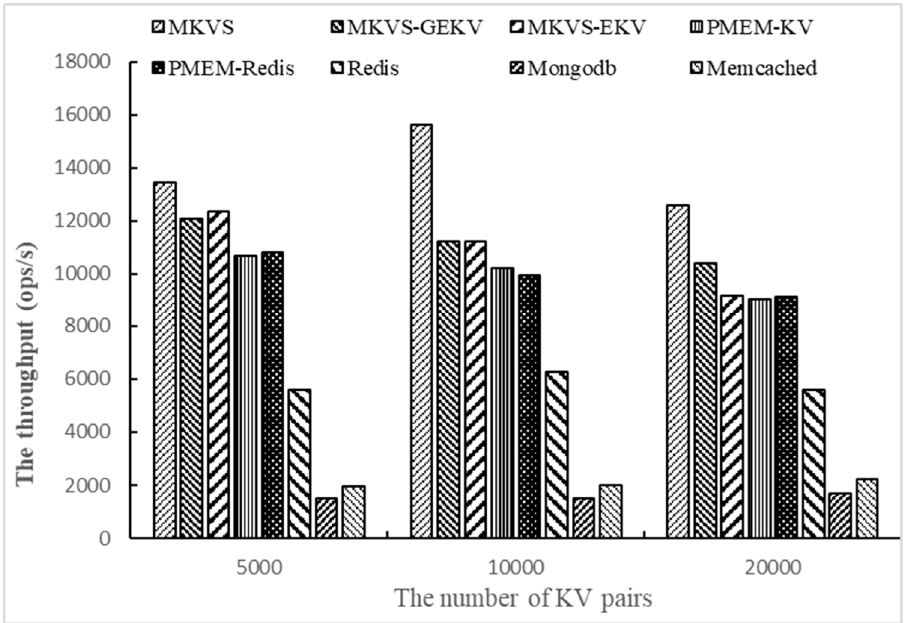
Figure 3. The throughput of changing the number of KV pairs with Workloadb.